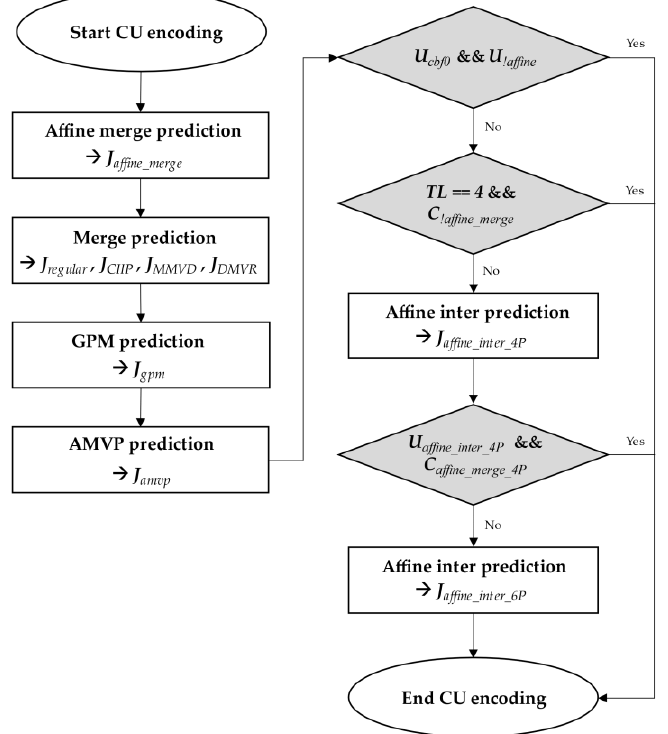
Figure 5. Block diagram of the proposed